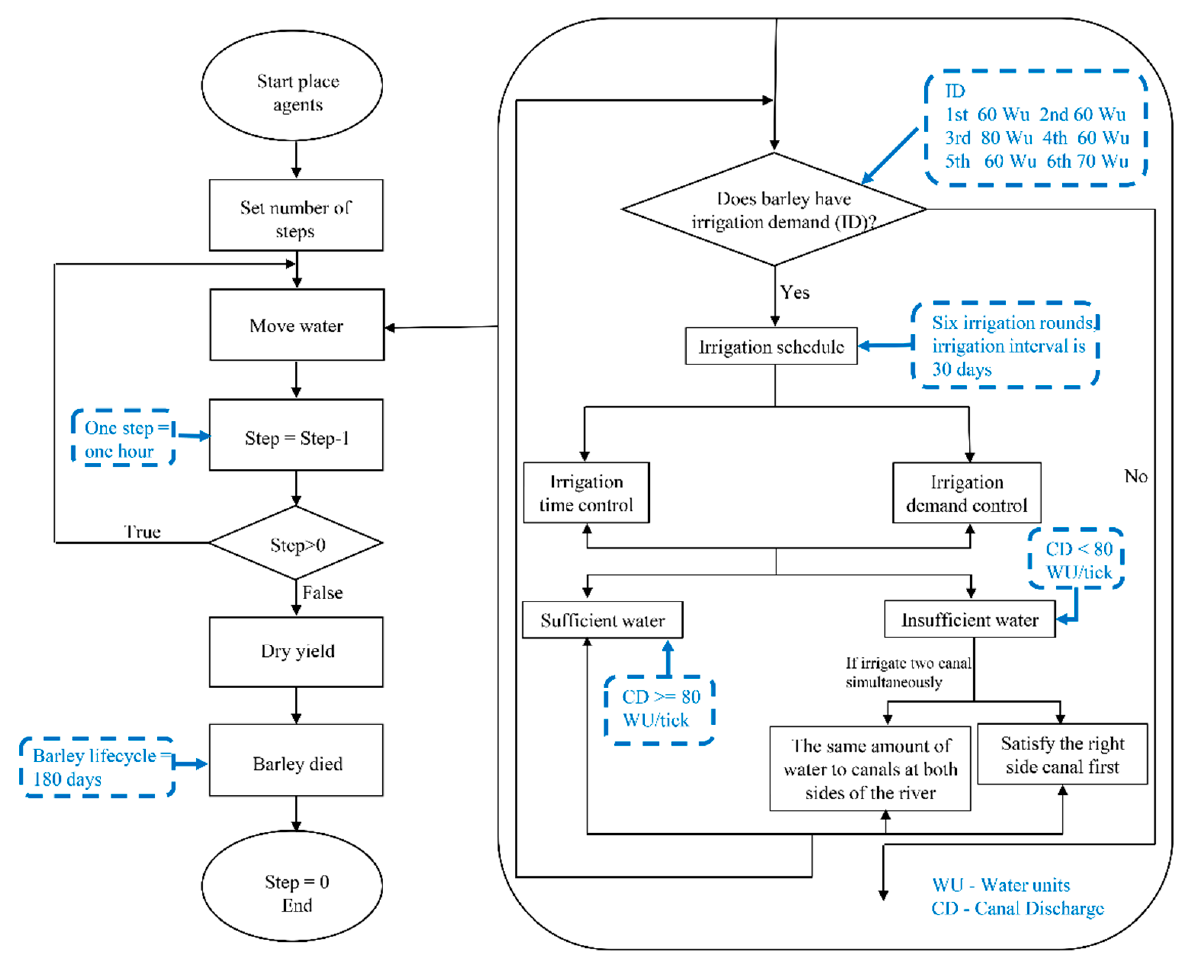
Figure 1. Process overview of the IRABM.